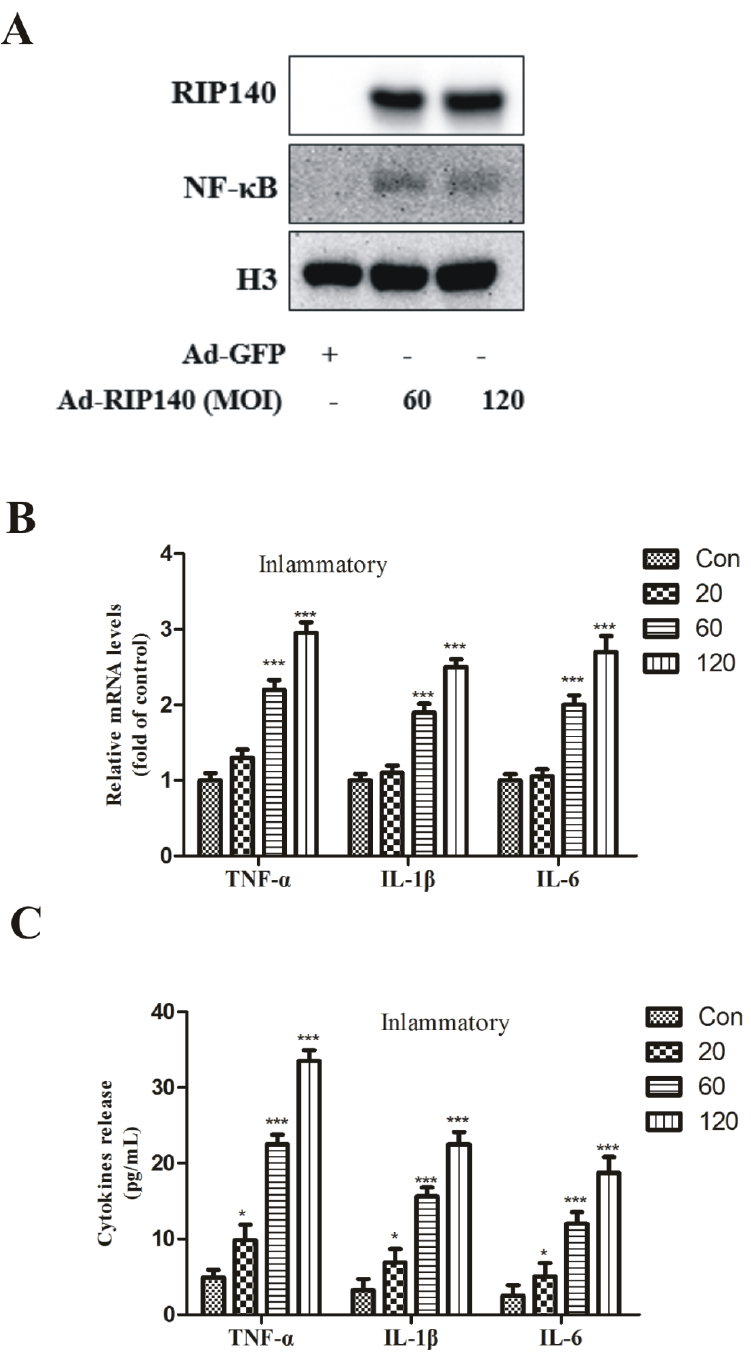
Figure 3. NF- κ B signaling activated following RIP140 overexpression. RPE cells were infected with adenovirus overexpressing RIP140 (MOI 60, 48 h) or GFP control. ( A ) The translocation of p65. ( B ) TNF- α , IL-1 β , and IL-6 mRNA levels were increased in RIP140 groups compared with control group. ( C ) TNF- α , IL-1 β , and IL-6 release levels were consistent with the mRNA levels. * p < 0.05, *** p < 0.001 vs. Ad-GFP